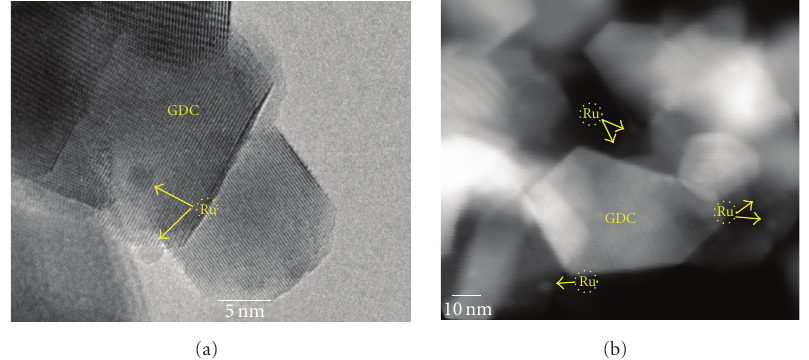
Figure 10: High resolution (a) and scanning mode (b) TEM images of the postreformed Ru-GDC catalyst; individual noble metal particles ( ∼ 2nm) are clearly visible.